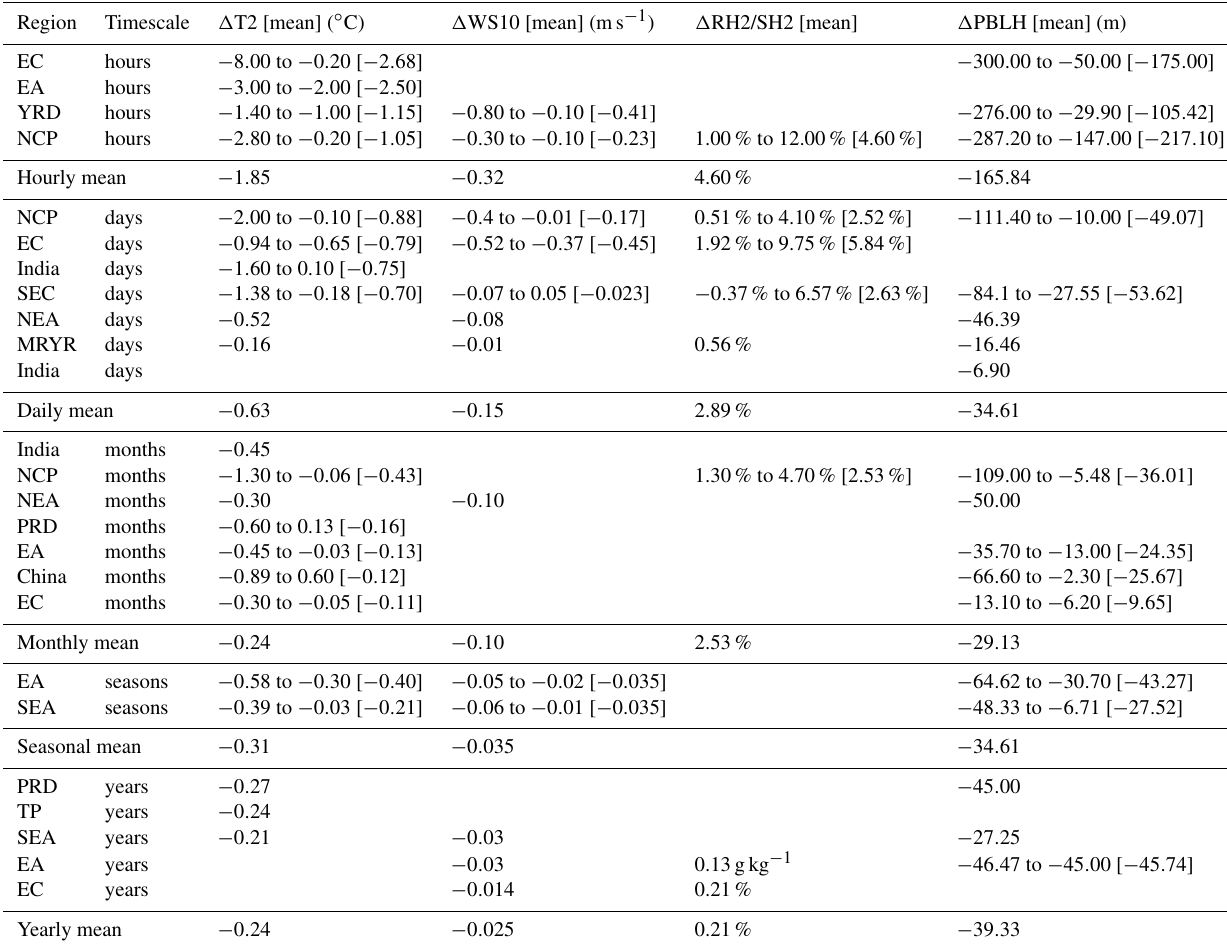
Table 6. Summary of variations of surface meteorological variables and planetary boundary layer height (PBLH) caused by aerosol feedbacks simulated by two-way coupled models (WRF-Chem, WRF-CMAQ, GRAPES-CUACE, WRF-NAQPMS, and GATOR-GCMOM) in different regions of Asia and at different temporal